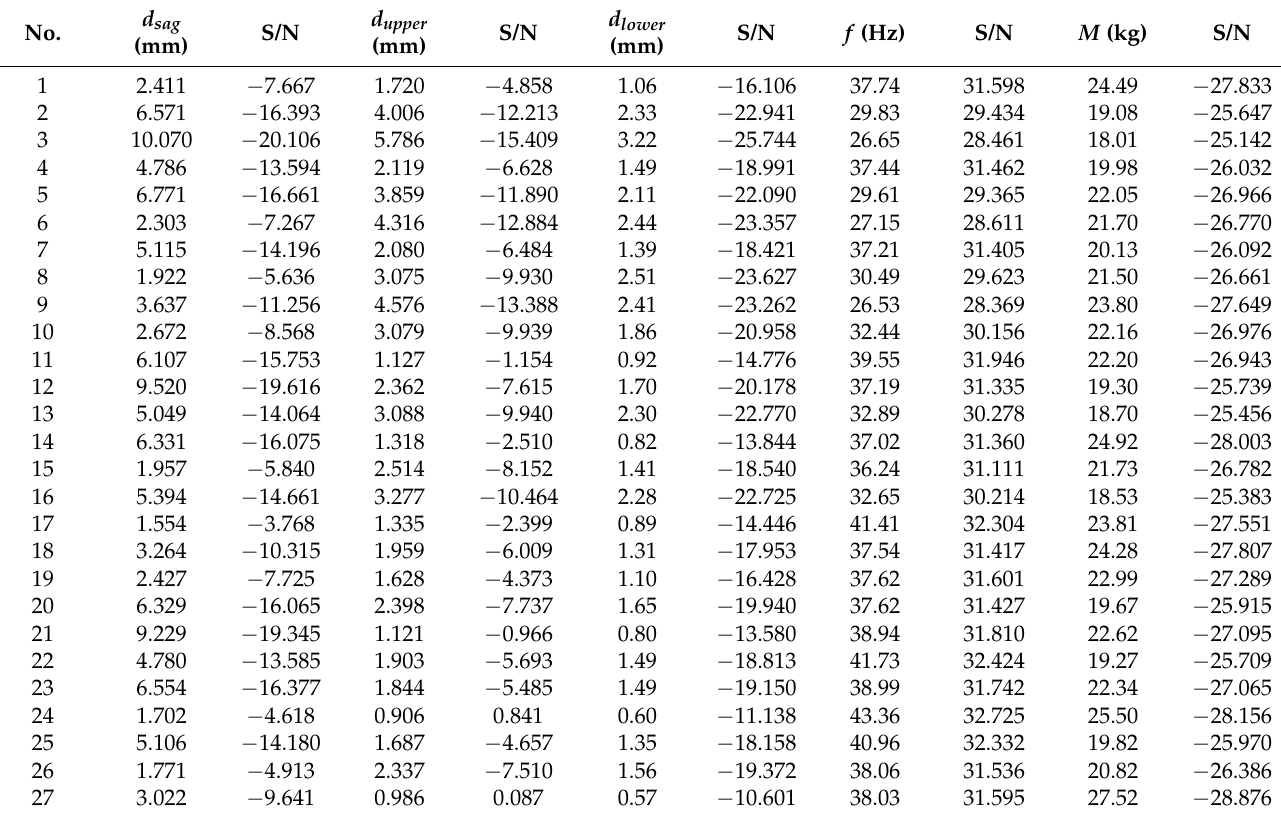
Table 5. Simulation results and corresponding S/N